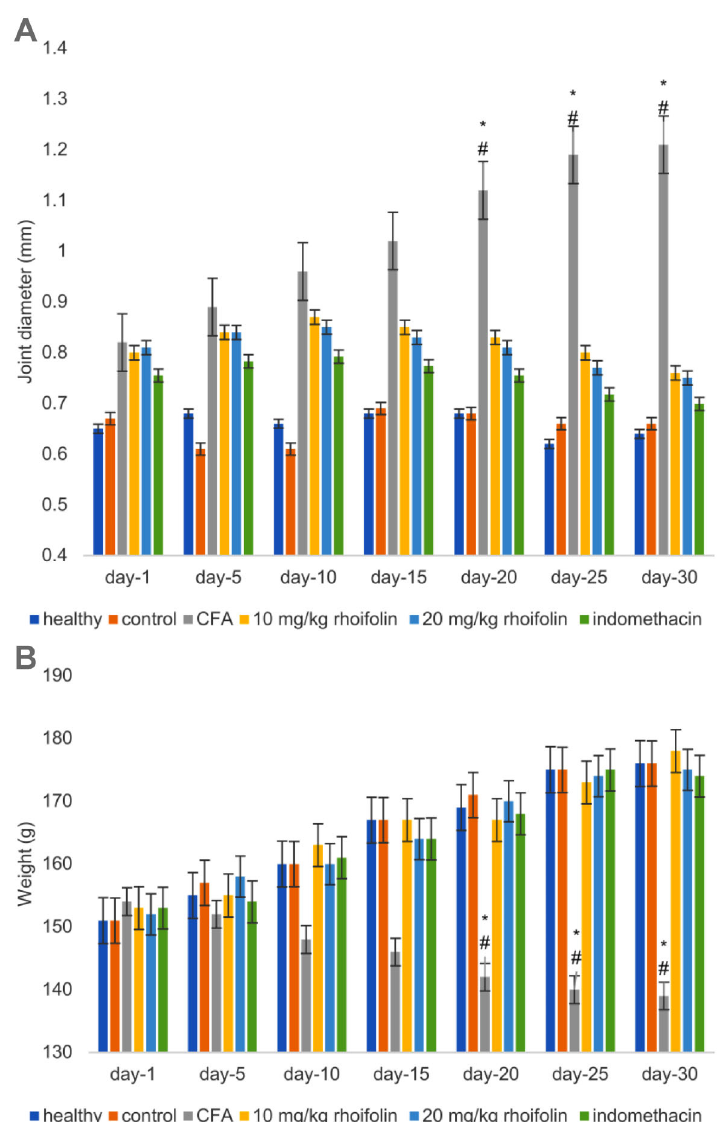
Figure 1. Effect of rhoifolin treatment on paw edema as estimated by measuring the joint diameter on complete Freund ’ s adjuvant (CFA)-induced edema ( A ). Effect of rhoifolin treatment on the body weight of CFA-induced animals ( B ). Data are reported as means ± SE. # P p 0.05 compared to 10 mg/kg rhoifolin group. *P p 0.05 compared to 20 mg/kg rhoifolin group